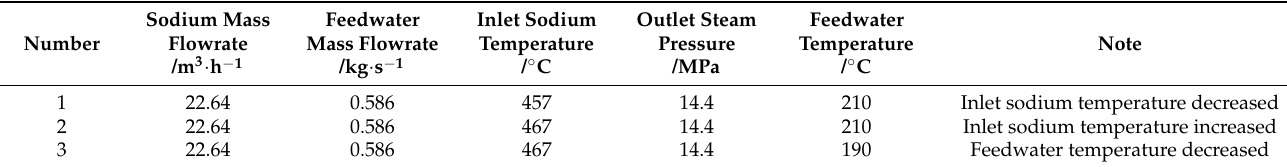
Table 2. Transient experiment conditions